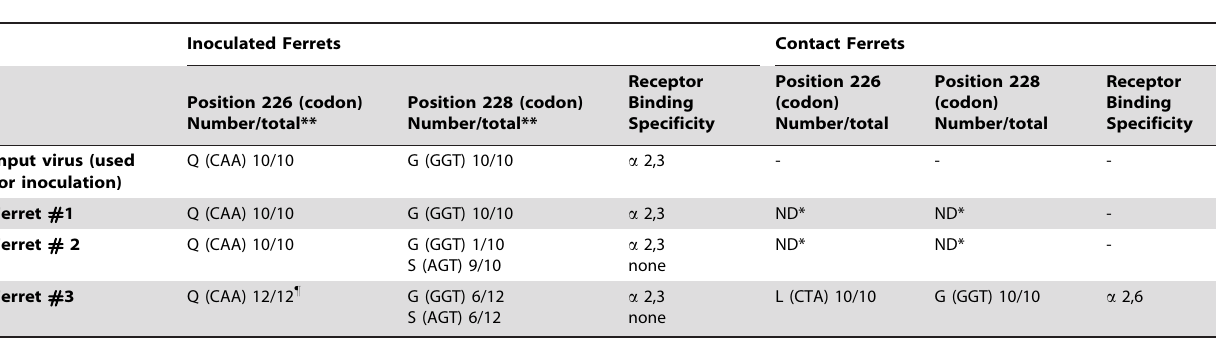
Table 2. Composition of amino acids responsible for receptor binding among plaque purified viruses obtained from ferret nasal washes.